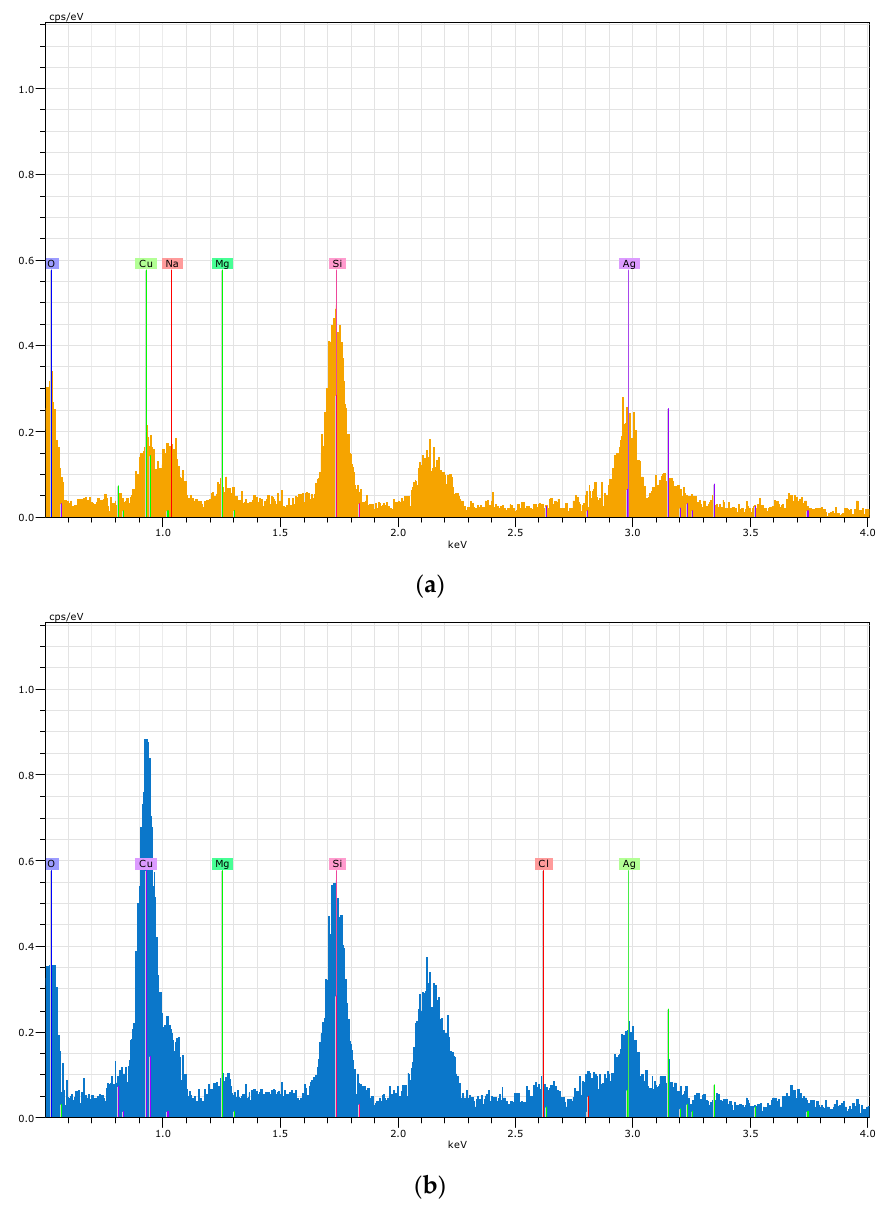
Figure 11. Energy dispersive X-ray analysis (EDX) analysis of the reflector silver layer before ( a ) and after of 480 h ( b ) of the CASS test.